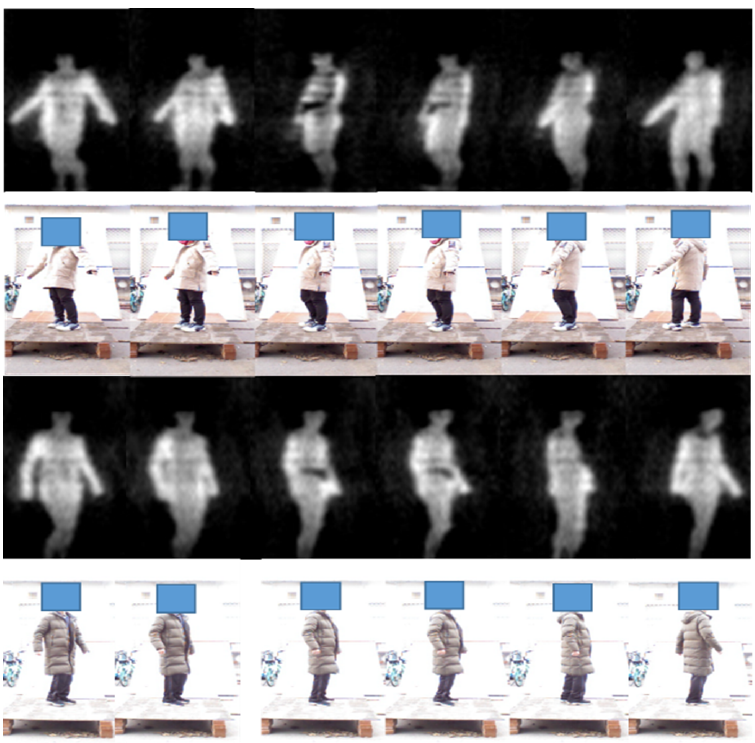
Figure 17. Examples of metallic threat detection under specific imaging angle. Table 4. Confusion Matrix of Threat Classification on dataset